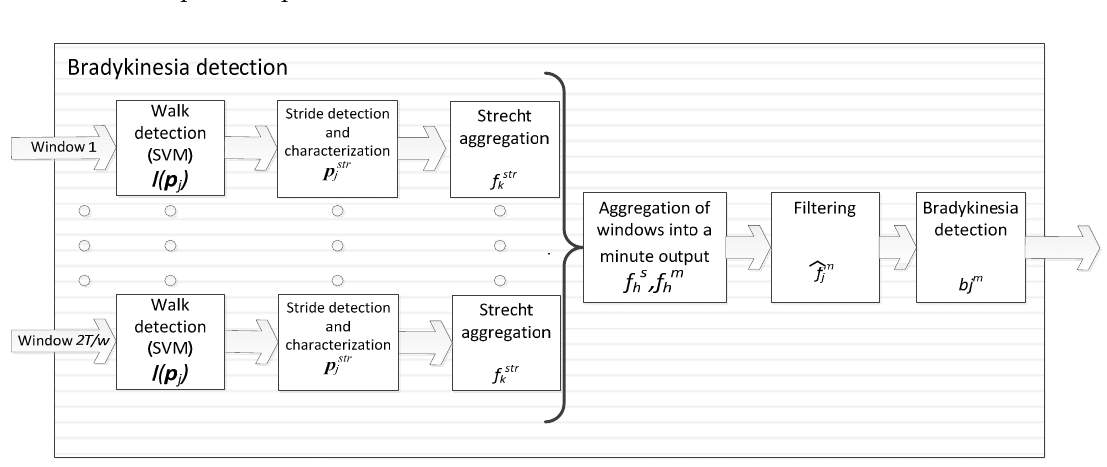
Figure 4. Block diagram of the bradykinesia algorithm.